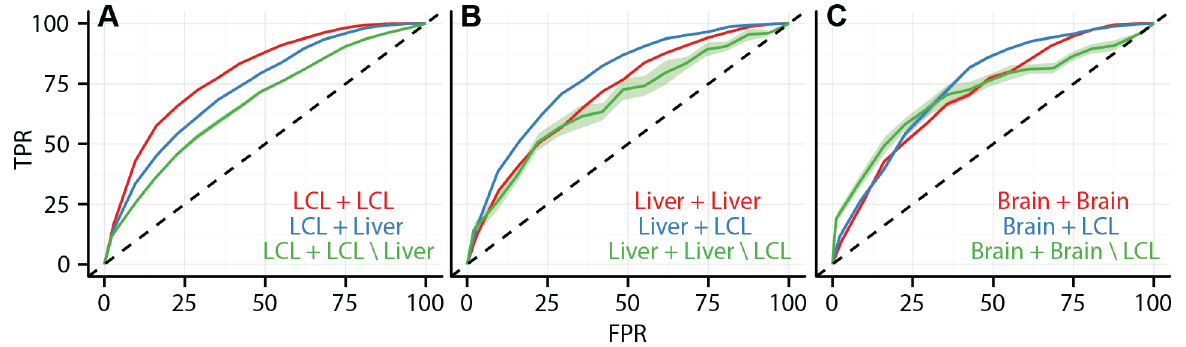
Figure 7. Data integration predicts cell type specificity of eQTLs. ROC curves depicting the performance of a random forest classifier to predict within cell type reproducibility (red), between cell type reproducibility (blue), and within cell type specific reproducibility (green). Predictions plotted separately for (A) LCL/LCL/Liver, (B)Liver/Liver/LCL, and (C) Brain/Brain/LCL. The classifier was trained on a diverse collection of CREs (see Methods and Supplement for complete data set description). True positive rates (y-axis) and false positive rates (x-axis) were quantified by ten fold cross validation.